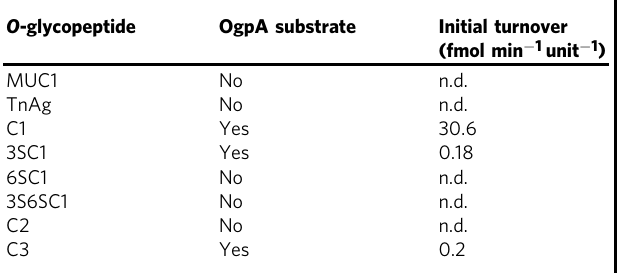
Table 1 Hydrolytic activity of OgpA determined by reverse- phase HPLC